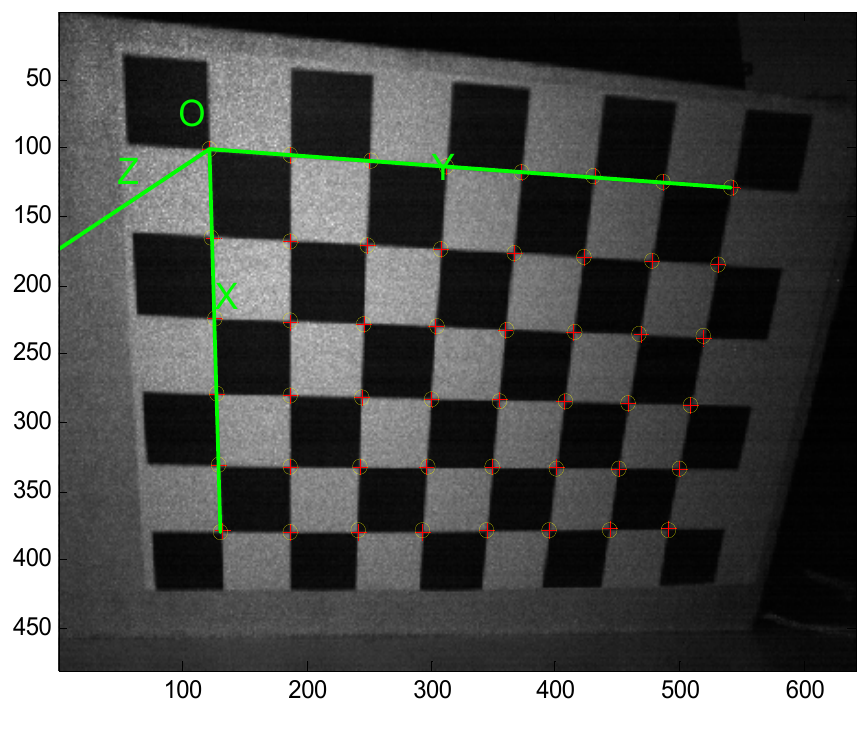
Figure 12. Corner extraction process.